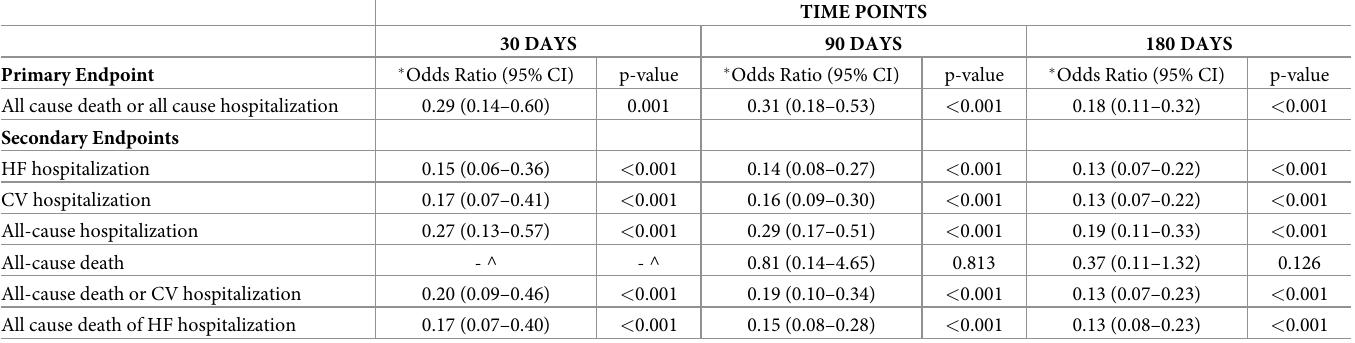
Table 2. Multivariable adjusted binary logistic regression analyses evaluating the outcome of HF program management vs. usual care on clinical outcomes 30, 90 and 180 days after